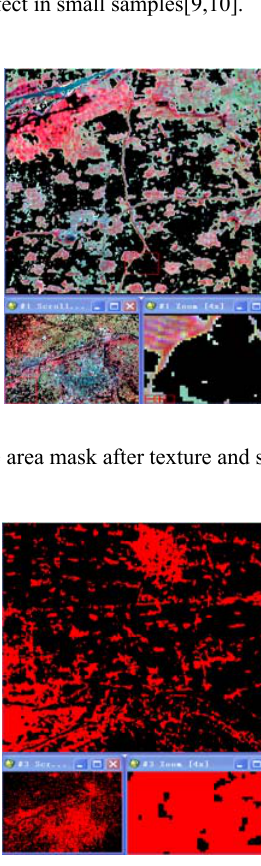
Fig.8 Coarse man-made area extracted by SVM in mask HJ